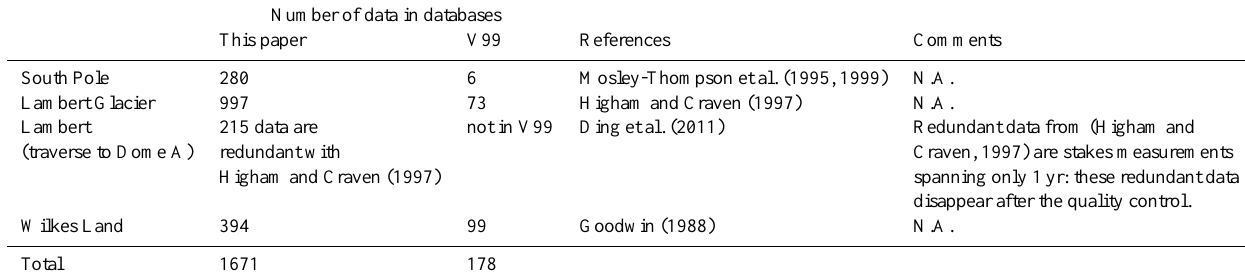
Table 2. SMB datasets, and available data at each step. Name in the text Filtering No. of observations Full SAMBA-LGGE database Full updated database before any filtering (but excluding 5548 digitalized data from Bull, 1971). “A” rated data Strict quality control (see Table 3) , only “A” rated 3539 data are retained. For 20th century model validation Blue ice data, data covering more than 70yr, and data with 3242 differences in elevation of more than 200m from the digital elevation model from Bamber et al. (2009) were